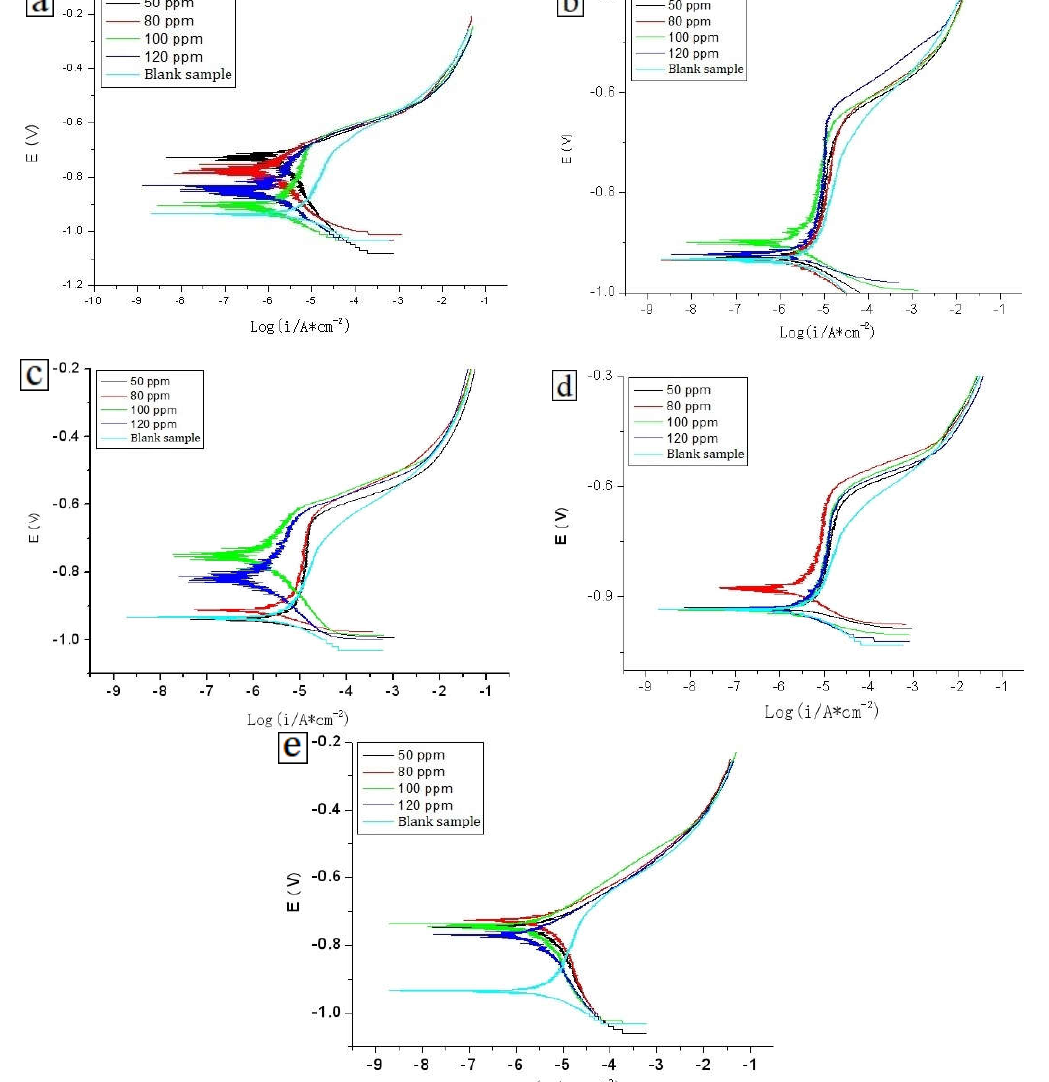
Figure 5. Polarization curves of the corrosion inhibitors: ( a ) HHS08 − 1#, ( b ) HHS08 − 3#, ( c ) PD43 − 1#, ( d ) RX − 21#, and ( e ) YD − 03# with different concentrations. ( d ) RX − 21#, and ( e ) YD − 03# with different